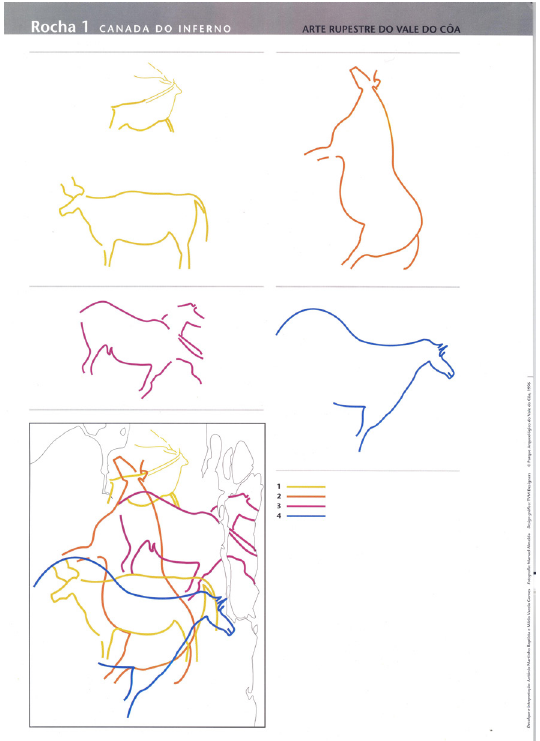
Figure 13. Relative chronology of superimposed motifs in Canada do Inferno Rock 1, from 1 (oldest) to 4 (youngest). The two- headed horse motif depicting motion belongs to the panel’s third engraving phase. Drawing in Zilhão (1997, p.